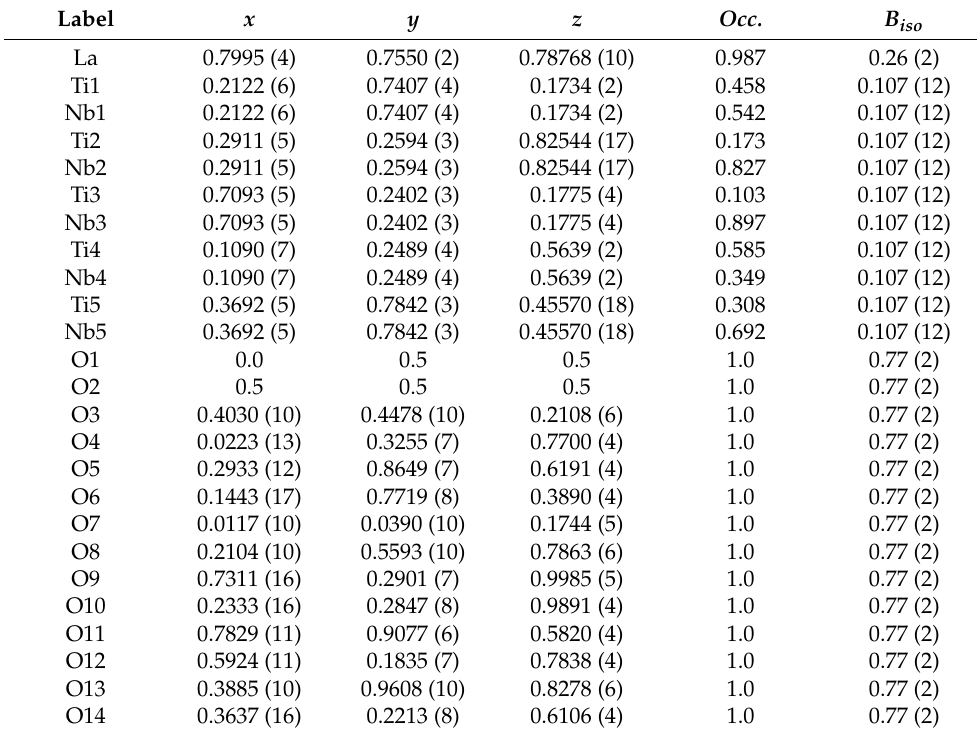
Table 2. Fractional atomic coordinates, site occupation parameters and atomic displacement